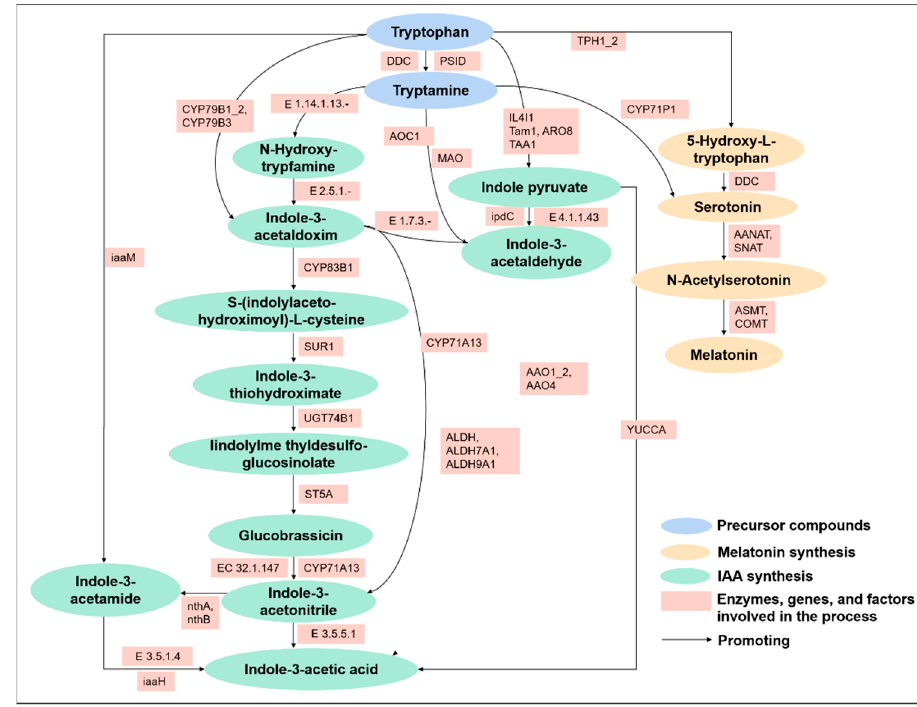
Figure 1. Synthesis pathways of IAA and melatonin in tryptophan metabolism.